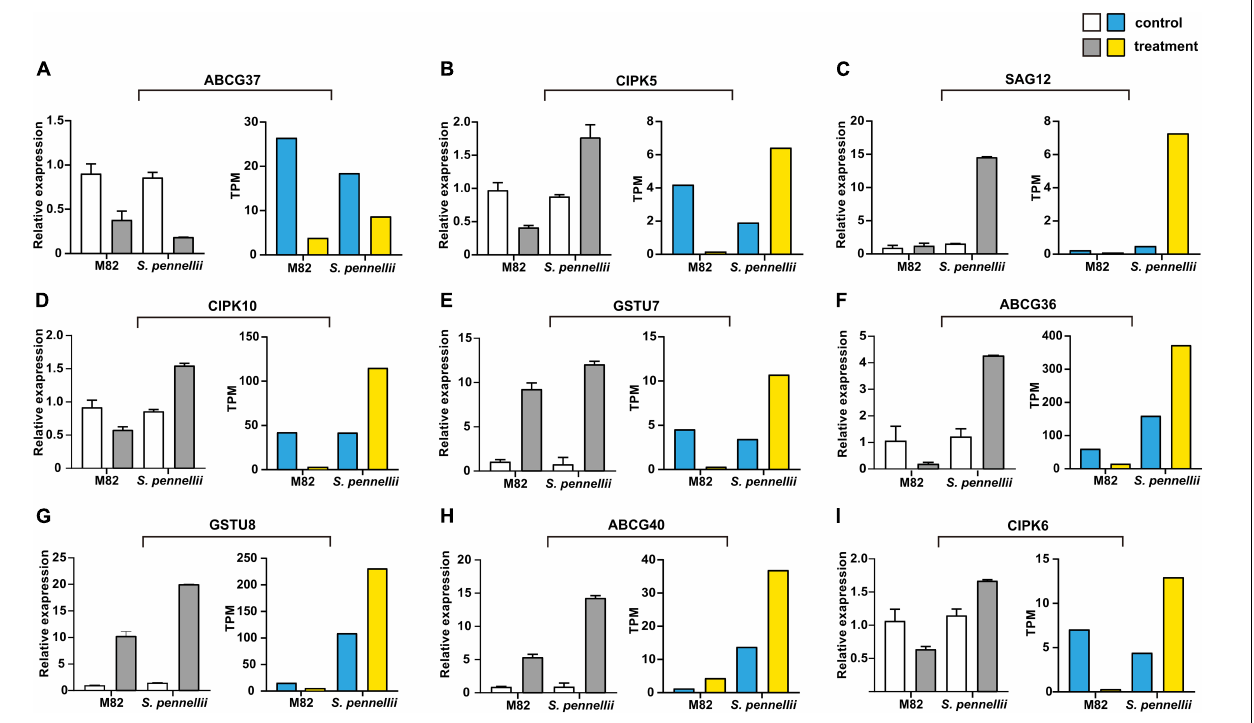
FIGURE 7 | qRT-PCR validation of the target genes of salt-responsive lncRNAs. (A–I) The qRT-PCR results are represented on the left graphs, the RNA-seq results of mRNAs are represented on the right graphs. The error bars represent the standard error of replicates. The white and blue bars represent the control samples, the gray and yellow bars represent the salt treatment